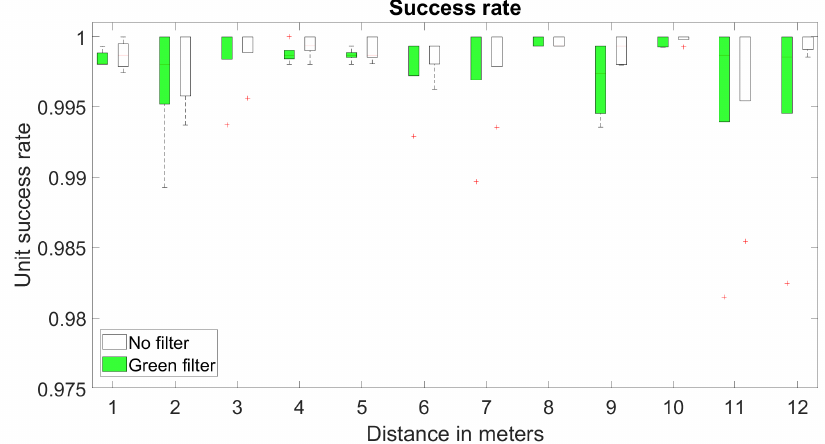
Figure 13. Box plot of attenuation of the signal with respect to distance using no filter.